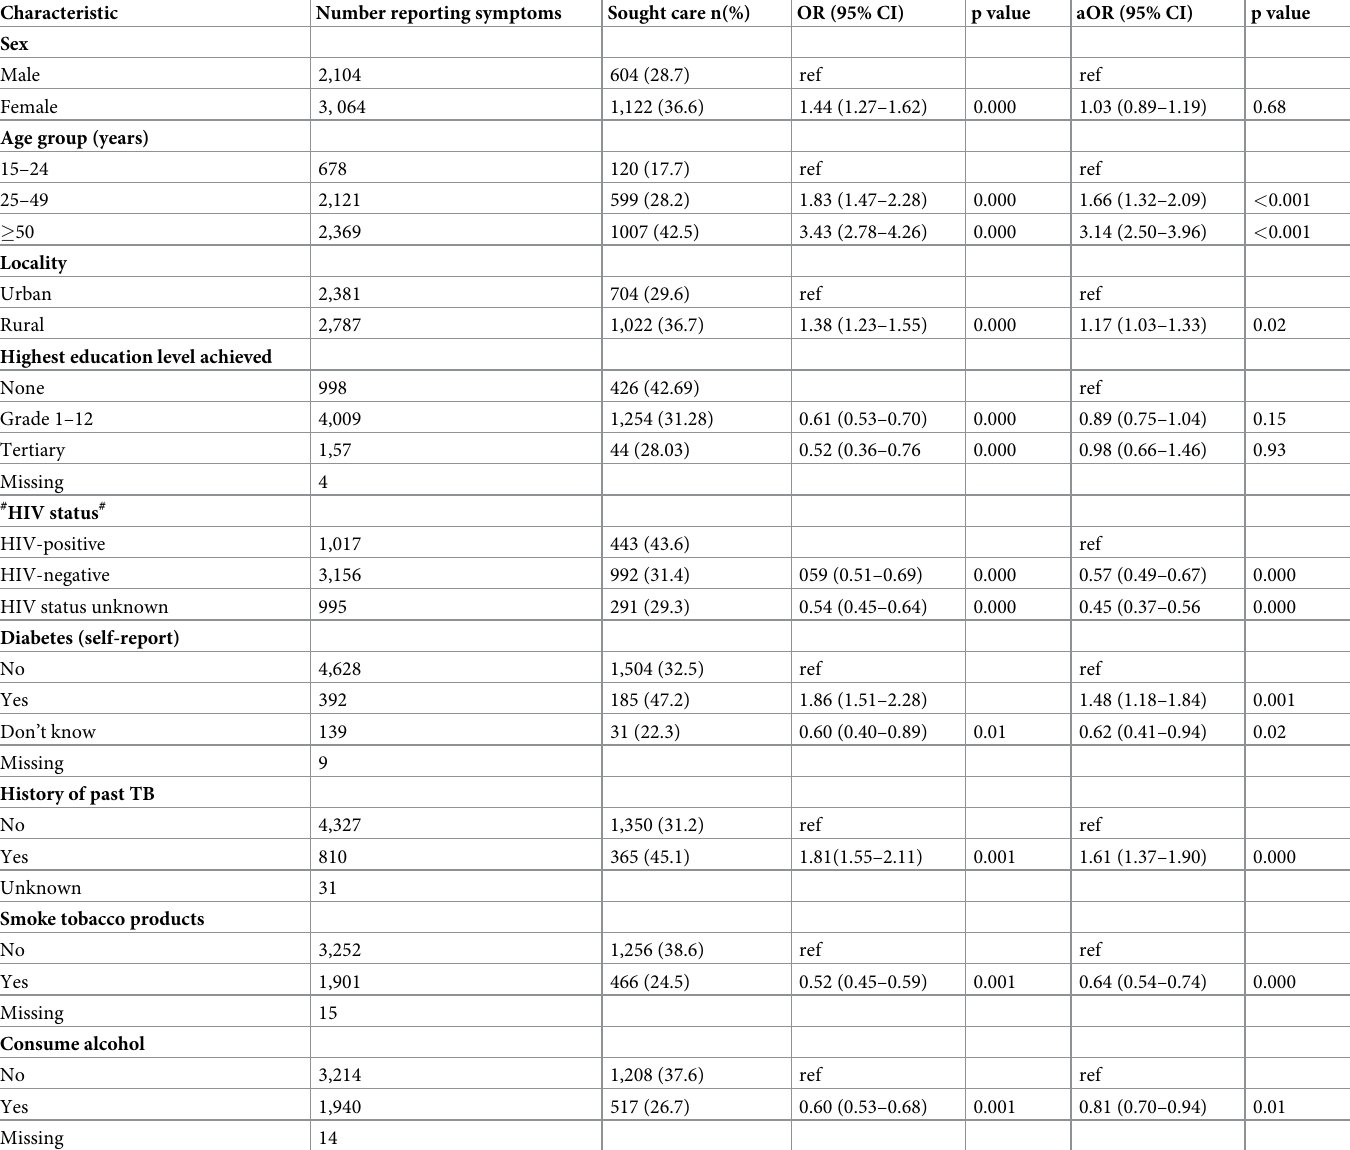
Table 2. Factors associated with self-reported care seeking for TB symptoms in a community survey, N = 5168.